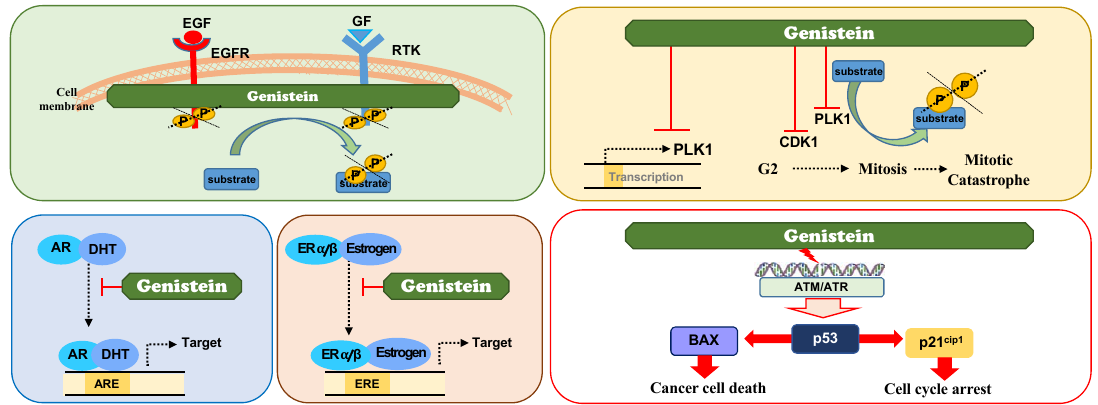
Figure 2. Action mechanisms of genistein to exert anticancer e ff ects. Genistein exhibits anticancer e ff ects by inhibiting the activities of receptor tyrosine kinase including EGFR and serine / threonine cell cycle regulatory kinases such as PLK1 and CDK1. Genistein also suppresses the transcriptional expression of PLK1. It is also considered as a tissue-specific hormone